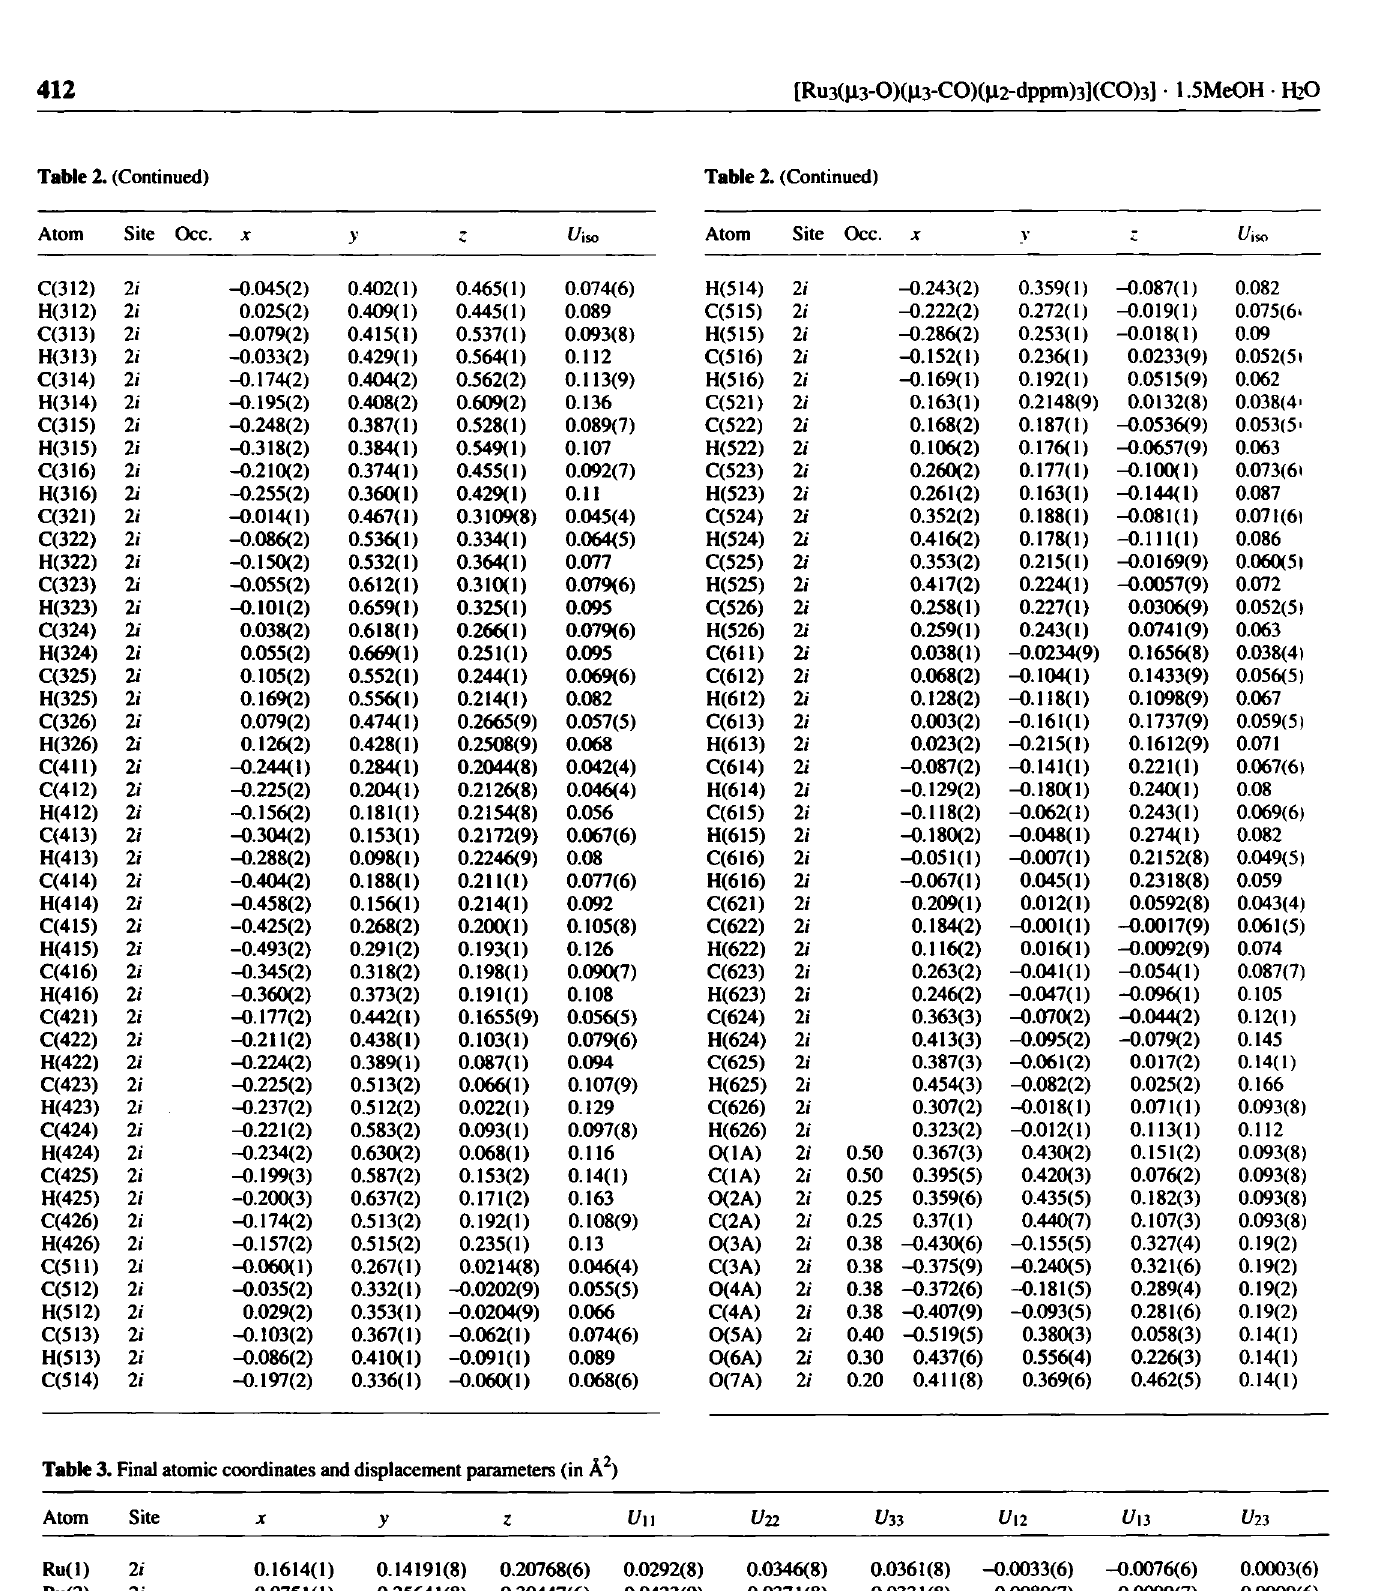
Table 3. Final atomic coordinates and displacement parameters (in Â 2